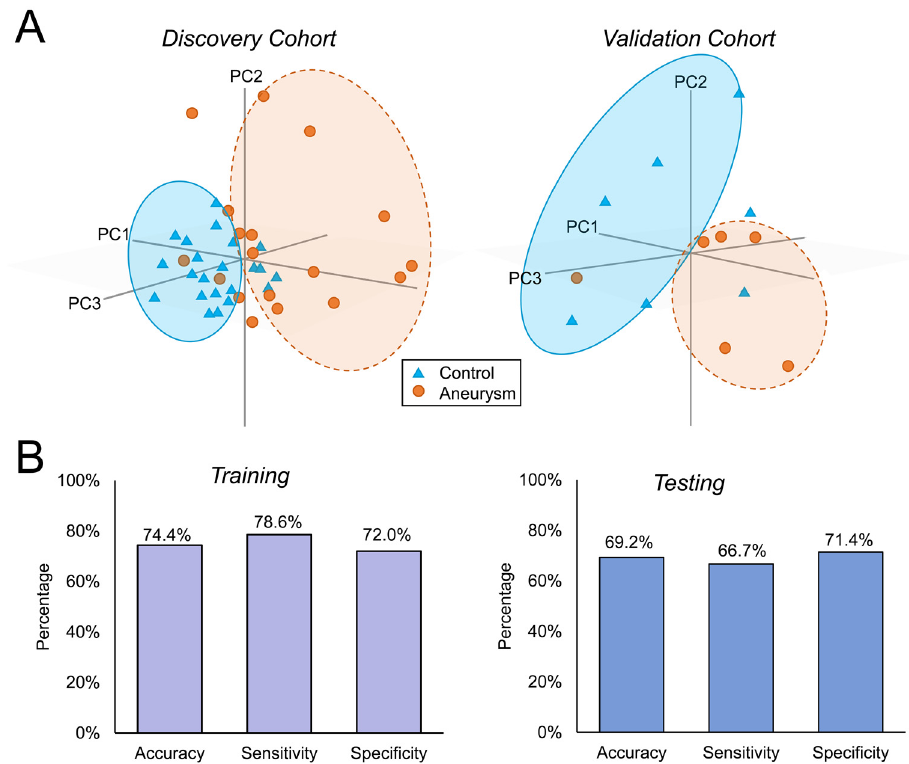
Figure 4. Replication study in a validation cohort of 13 patients (6 with IAs). ( A ) The two plots show principal component analysis performed using the 54 IA-associated genes in both the discovery (left) and validation (right) cohorts. The gene set is able to distinguish the IA samples (orange circles) from the controls (blue triangles) in a similar fashion. ( B ) Supervised machine learning was performed to determine how well the 54 genes delineated the IA from control samples in both datasets. The bar graph on the left shows that training an Ensemble classifier in the discovery cohort yielded a mean cross-validation accuracy, sensitivity, and specificity ≥ 72%. In testing the validation dataset, our data shows that the model still had moderate performance, with an accuracy = 69.2%, a sensitivity = 66.7%, and a specificity = 71.4%.